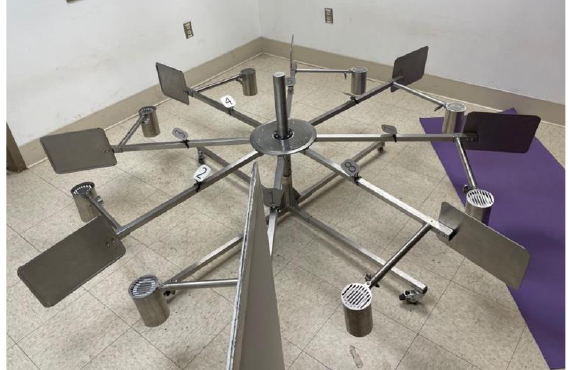
Figure 1. A photo of the 8-port scent wheel used in this study.